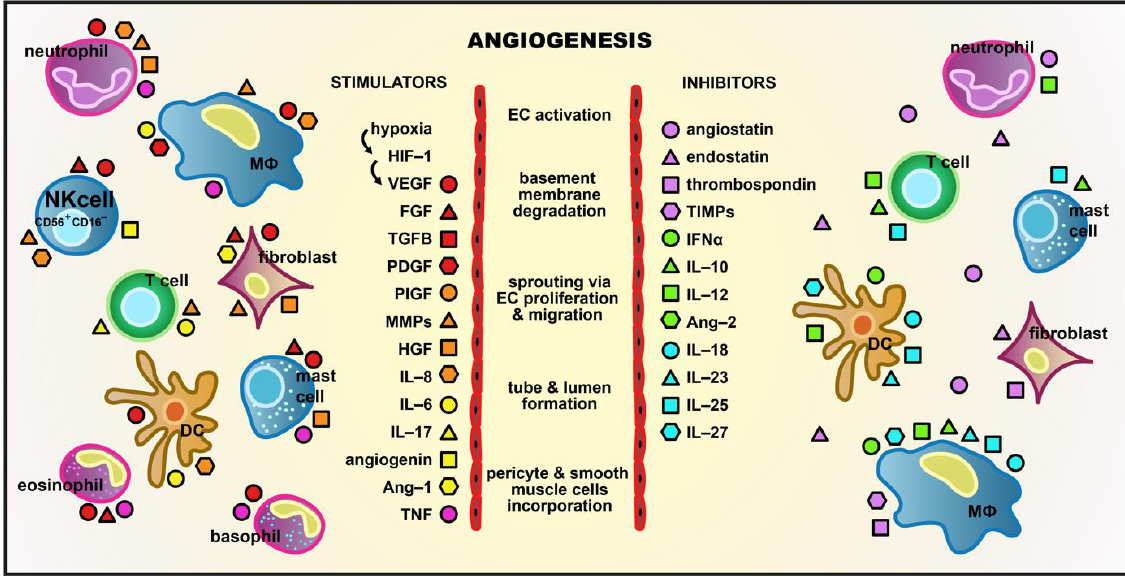
Figure 1. Stages of the angiogenesis process and its regulation. New blood vessel formation is upregulated by hypoxia, which stimulates hypoxia-inducible factor-1 (HIF-1) leading to the vascular endothelial growth factor (VEGF) expression. VEGF, fibroblast growth factor (FGF), transforming growth factor (TGF), platelet-derived growth factor (PDGF), hepatocyte growth factor (HGF), placenta growth factor (PlGF), angiogenin, angiopoietin (Ang)-1, interleukin (IL)-8, IL-6, IL-17, matrix metalloproteinases (MMPs), and tumor necrosis factor (TNF) stimulate angiogenesis. Inhibitors of neovascularization include angiostatin, endostatin, thrombospondin, tissue inhibitors of matrix metalloproteinases (TIMP), interferon (IFN)- α , IL-10, IL-12, IL-18, IL-23, IL-25, IL-27, and Ang-2. The various kinds of cells participating in the regulation of angiogenesis, mainly by secreting stimulatory and/or inhibitory factors, include endothelial cells, macrophages (M Φ) , mast cells, fibroblasts, CD56 + CD16 - natural killer (NK) cells, T cells, neutrophils, basophils, eosinophils, and dendritic cells (DCs) [7,14 – 18] .